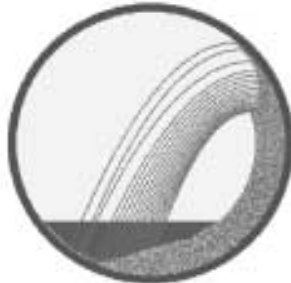
Fig. 11 Simulated Charge Profile Corresponding to a Lifter Bar of 120 mm and Angle of 90° for a 9.6 m diameter SAG